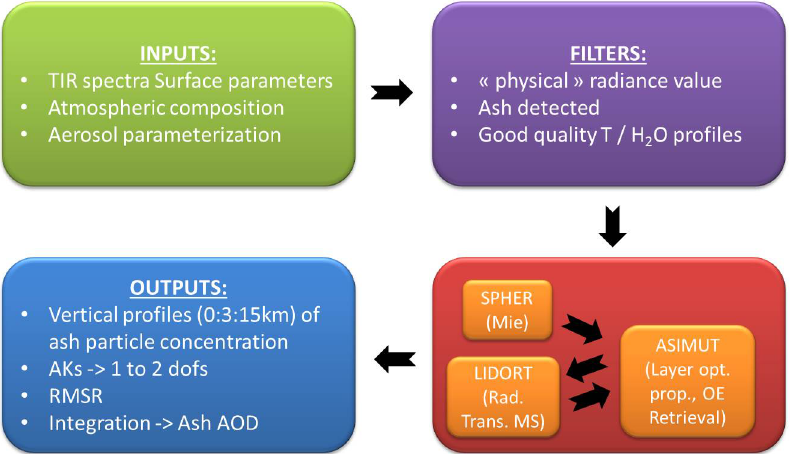
Figure 4. Schematic representation of the mineral aerosol profiling from infrared radiances (MAPIR) processing chain applied in this